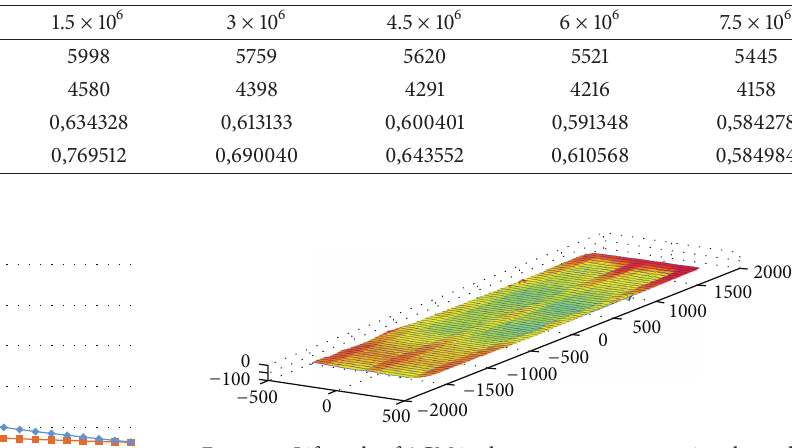
Table 4: Radial stress and strength resiliency values in ACM layers based on Ni.